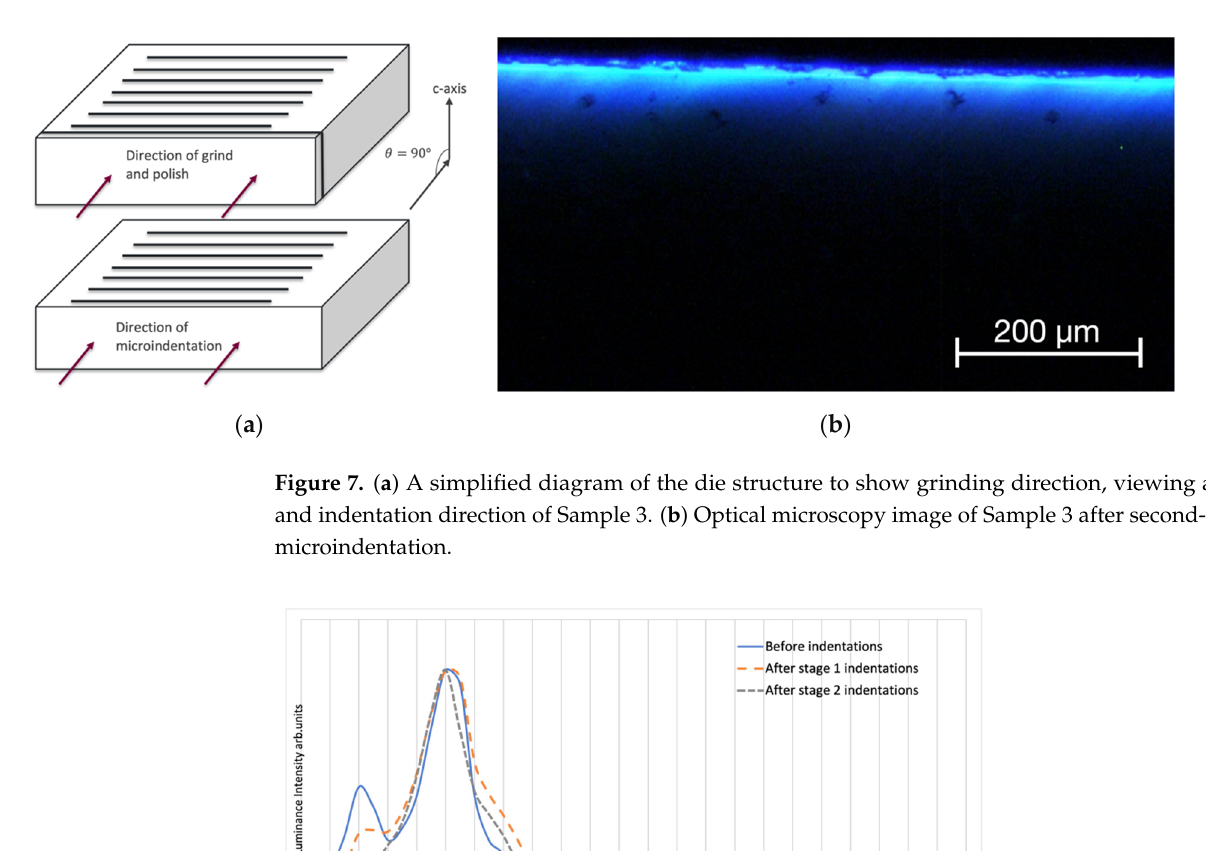
Figure 7. ( a ) A simplified diagram of the die structure to show grinding direction, viewing angle 161 and indentation direction of Sample 3. ( b ) Optical microscopy image of Sample 3 after second-stage 162 microindentation. Table 3. PV reading and intensity ratio of Samples 2 and 3.